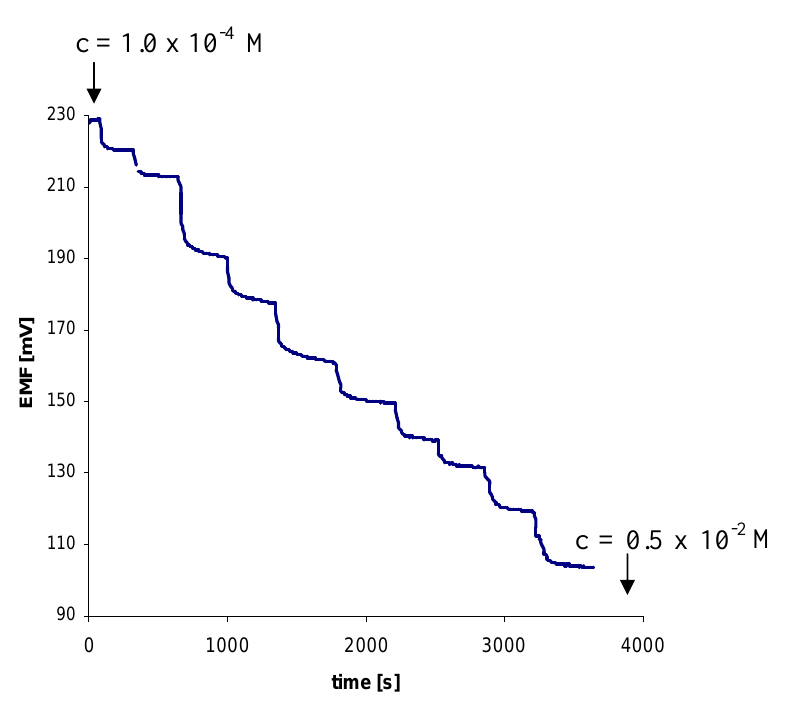
Figure 4 . Response time towards benzoic acid addition. Aliquot of the stock solution 1.0 x 10 -2 M analyte was added to 100.0 ml 0.01 M Na